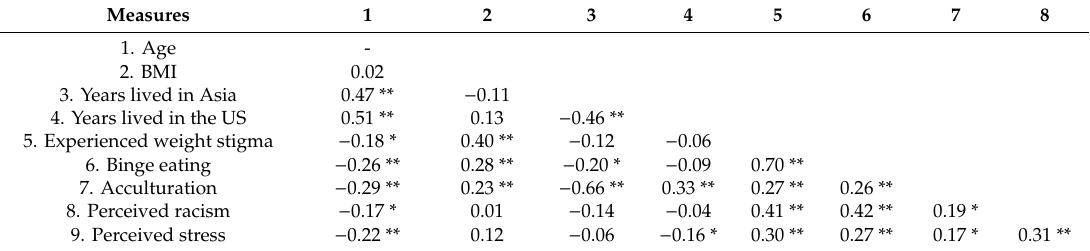
Table 3. Pearson correlation coe ffi cients between pairs of study variables ( n = 166).